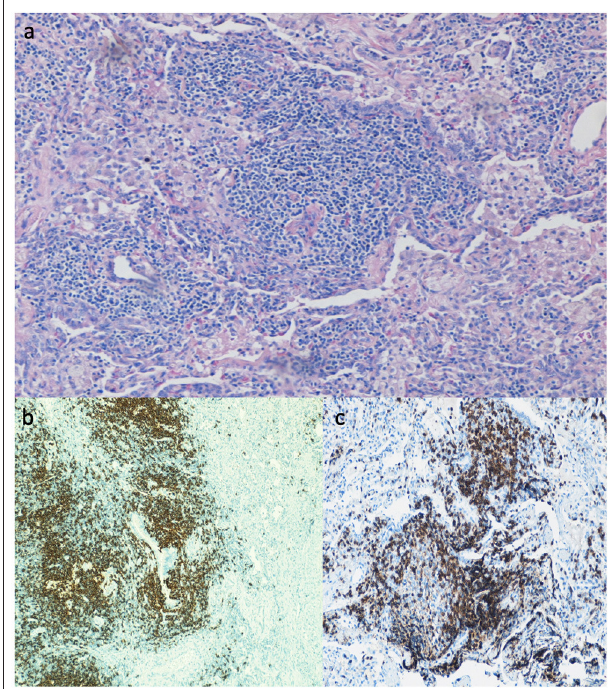
FIGURE 1 | Lung biopsy of CVID patient with ILD, showing the presence of a granuloma lesion, with presence of lymphocytes on H&E staining (a) , immunohistochemistry for CD20 (b) , and for CD3 cells (c) . Magnification of images is